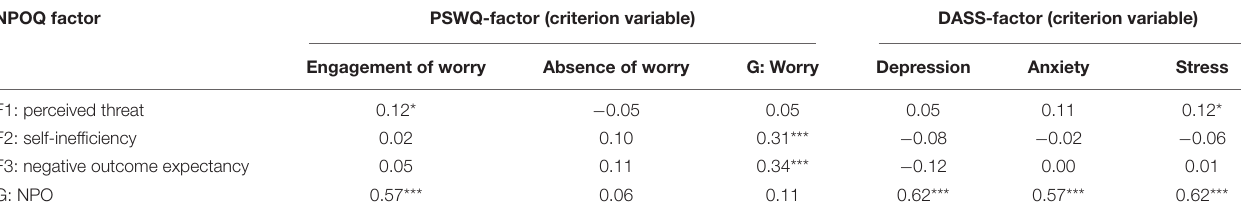
TABLE 4 | Standardized beta weights from structural regression model. NPOQ factor PSWQ-factor (criterion variable) DASS-factor (criterion variable) Engagement of worry Absence of